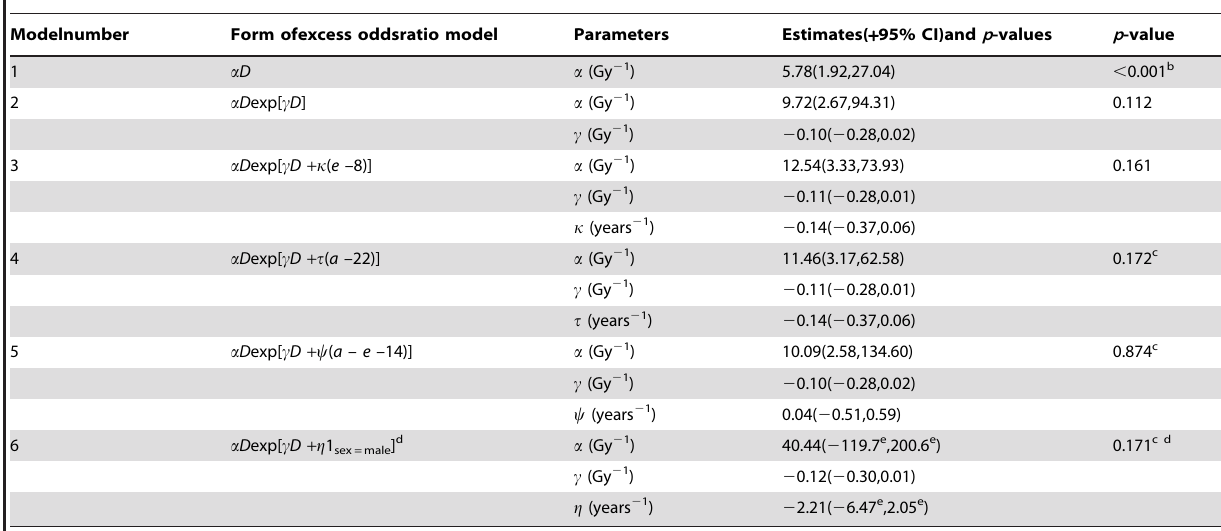
Table 3. Results of fits of optimal excess relative risk model (2) (maximum likelihood fits and 95% profile CI), all based on TD-10 dose estimates adjusted using 1 st regression calibration method (of Kukush et al. ). All models have underlying rates adjusted for age (treated categorically) and gender. Parameters are given (with 95% CI), with associated p -values. a Unless otherwise stated all CI are profile-likelihood based.